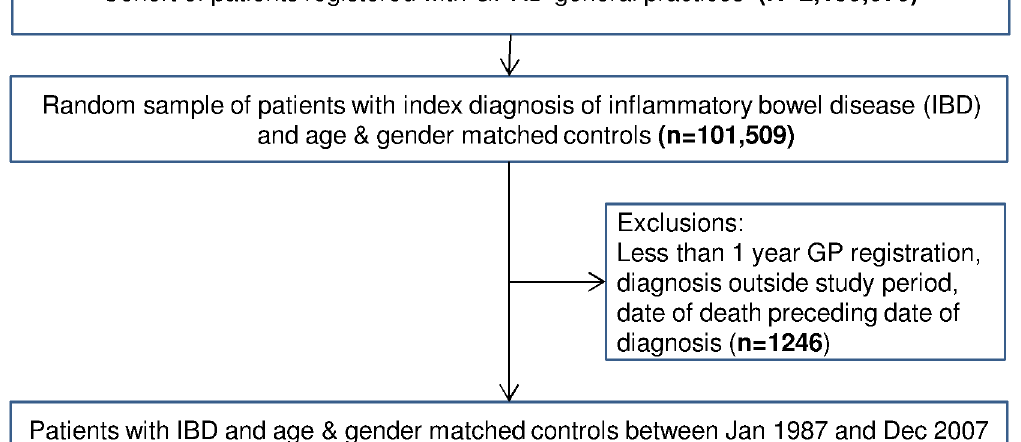
Fig 1. Cohort Flowchart. Selection of patients into two cohorts for analysis: COHORT A for descriptive analysis to examine the temporal relationship between IBD and IHD, and COHORT B for sub-group analysis of IHD cases which occurred following IBD diagnosis.